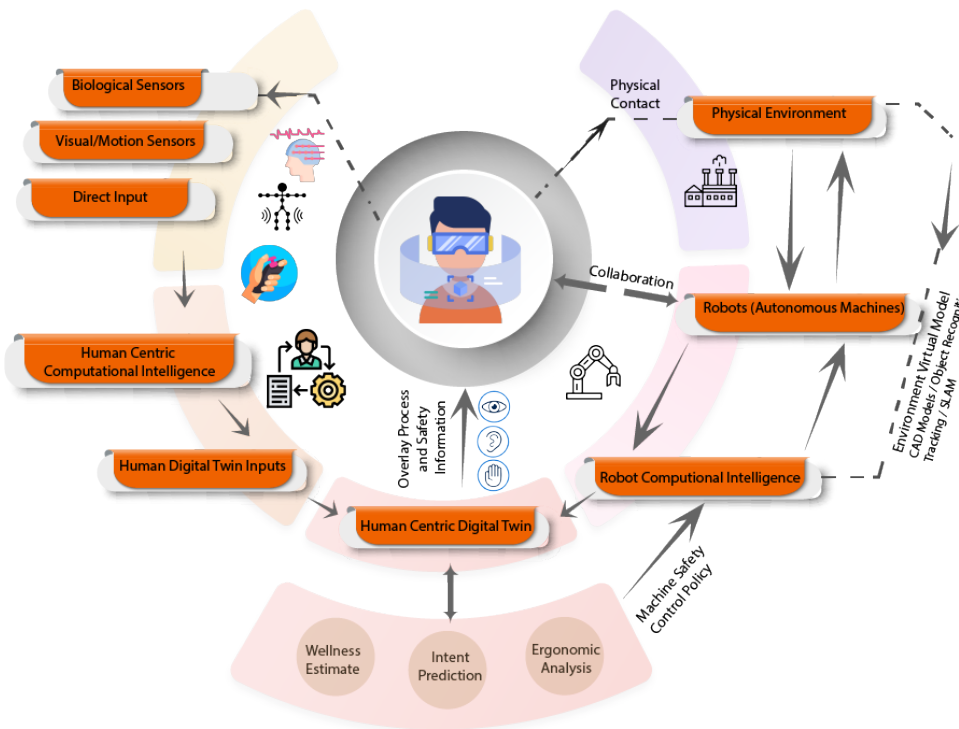
Figure 7. Generic framework for HCDT for safety and ergonomics.